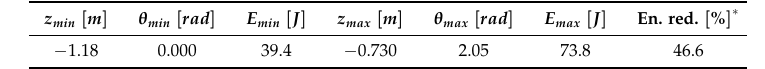
Figure 9. Energy consumption maps for Case (2). Table 6. Minimum and maximum energy solution for Case (3). ∗ Energy reduction w.r.t. E max